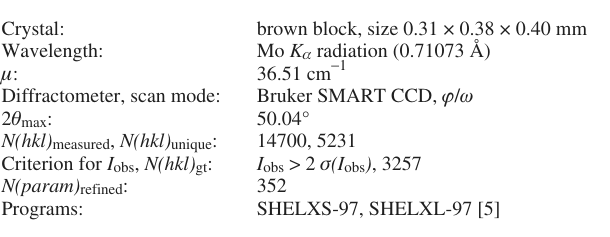
Table 1. Data collection and handling.